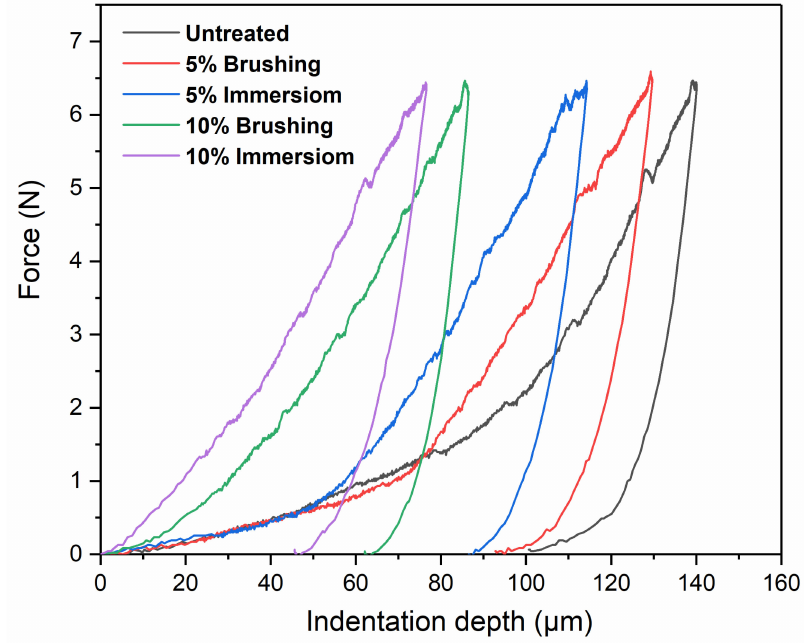
Figure 9. Representative force (N) vs. displacement ( µ m) curves obtained from Martens hardness measurements for the wood samples under study.